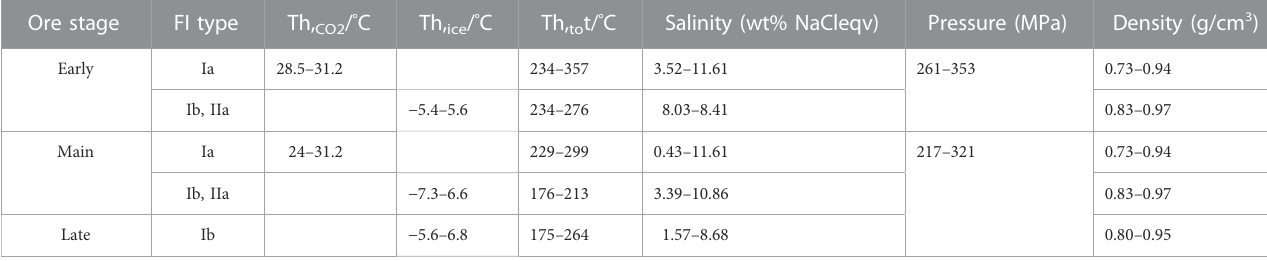
TABLE 1 Microthermometry results of ore-stage fl uid inclusions from the Zhaoxian gold deposit.